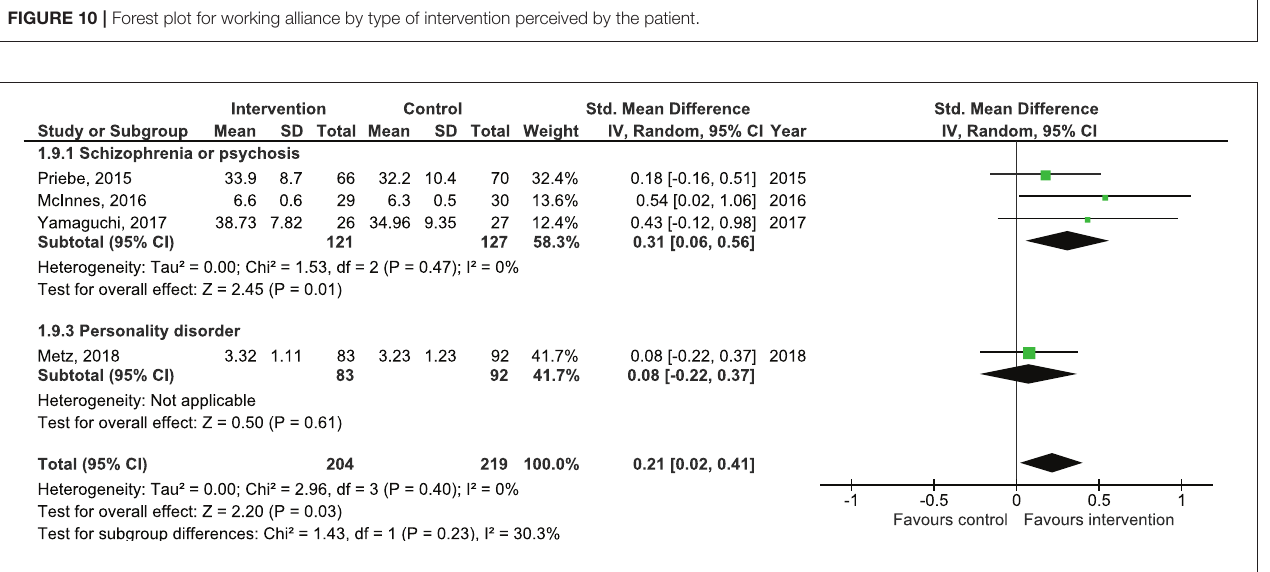
FIGURE 11 | Forest plot for working alliance by diagnosis perceived by the